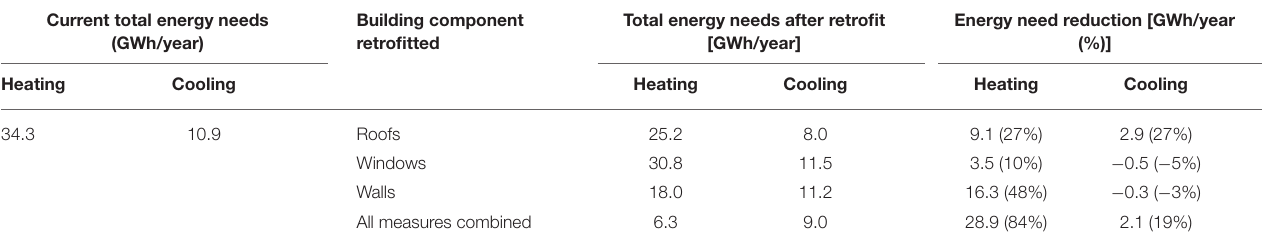
TABLE 5 | Energy needs for space heating and cooling, and the impact of different individual renovation measures for each building components. Current total energy needs